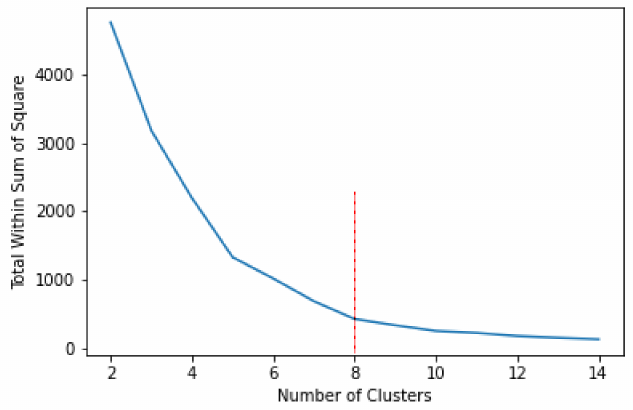
Figure 6. Curve of elbow method generated with data from the elderly 64 years or older. The number of the cluster was determined by looking at the point position on the “elbow”